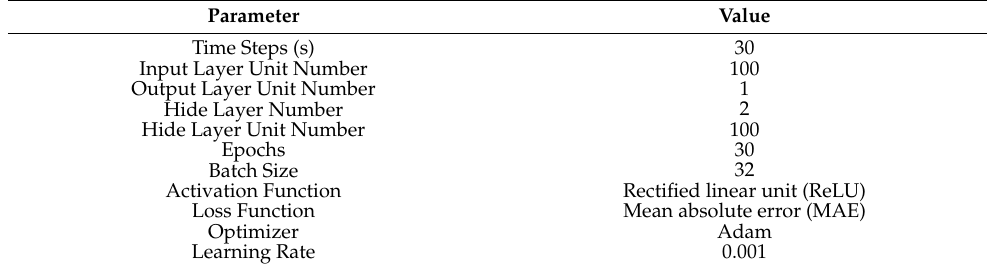
Table 4. Parameters setting of GRU model.